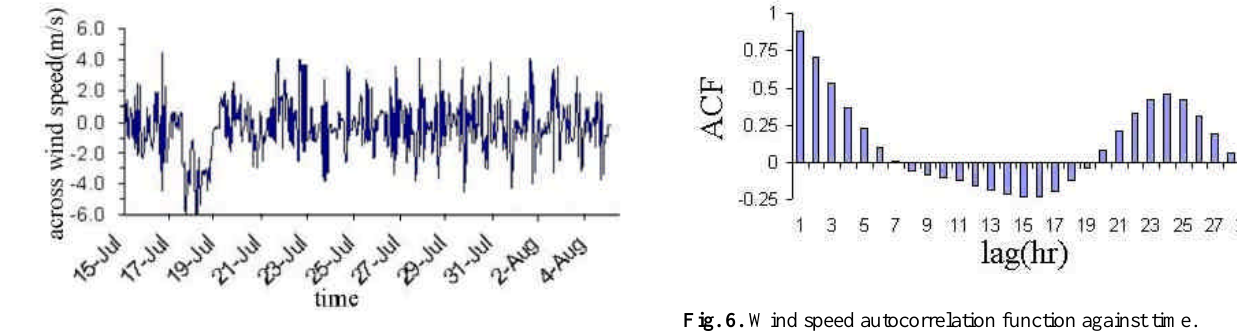
Figure4. Hourly time series of onshore wind against time (24h interval) Fig. 4. Hourly time series of onshore wind against time (24-h inter- val).